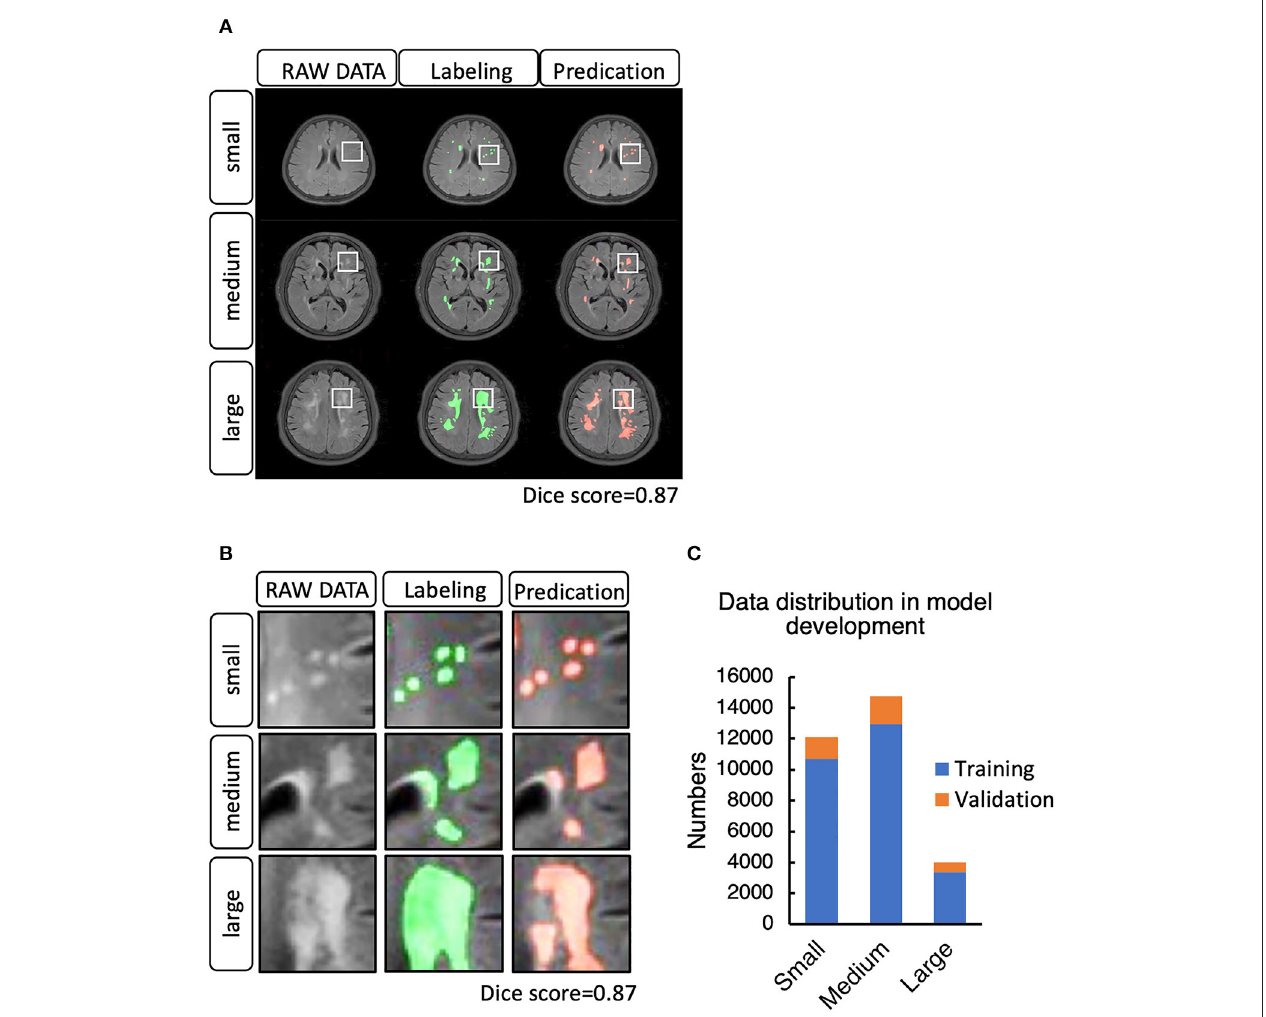
FIGURE 2 | (A) Example cases of white matter hyperintensities (WMHs) labeled manually and by the DLS system. (B) WMH lesion distribution in the training and validation step. (C) Data distribution in the model development for training and validation.